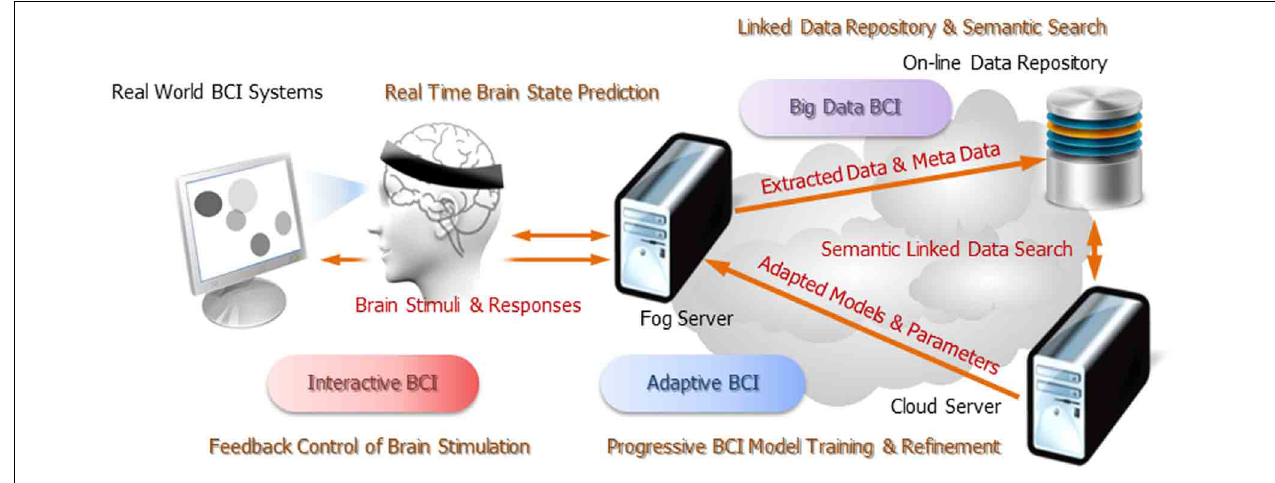
FIGURE 10 | Operation scenarios of pervasive EEG-BCI